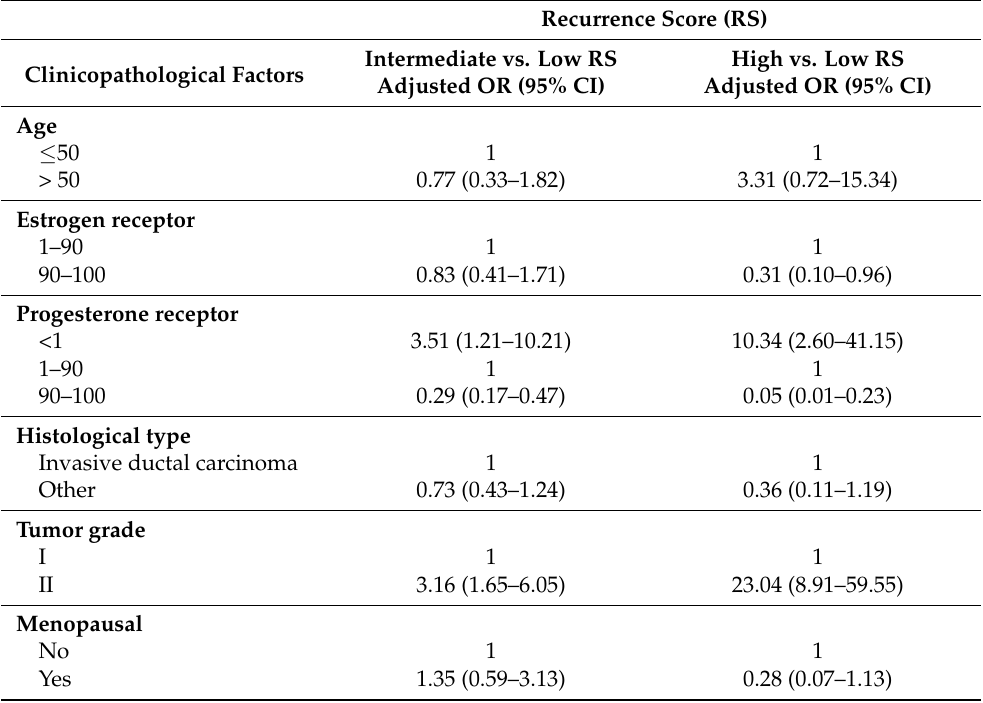
Table 3. Multinomial multivariable logistic regressions of association between clinicopathological factors and recurrence score categories.